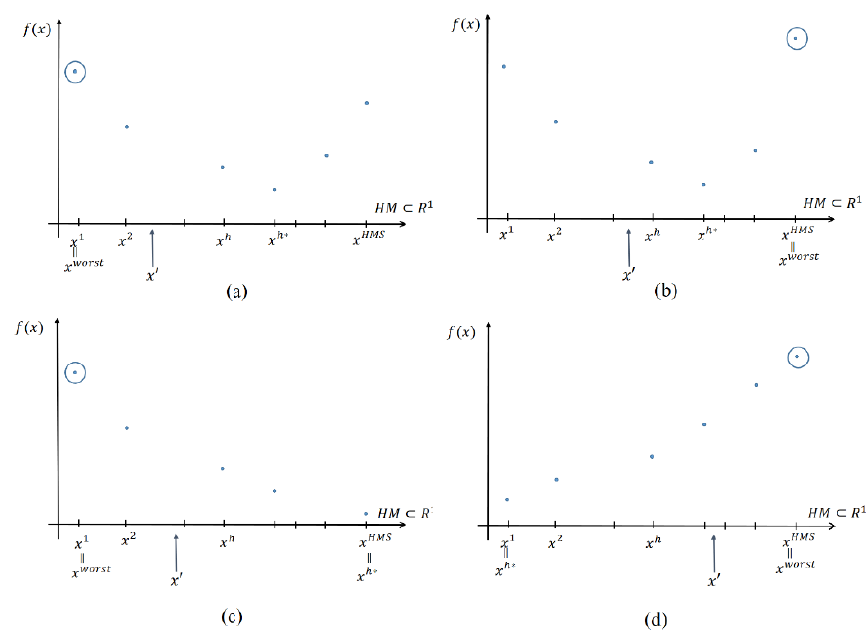
Figure 2. Candidate solutions and the worst element of one-variable functions.